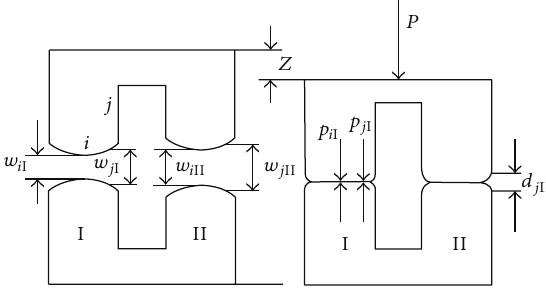
Figure 4: Model for loaded tooth contact